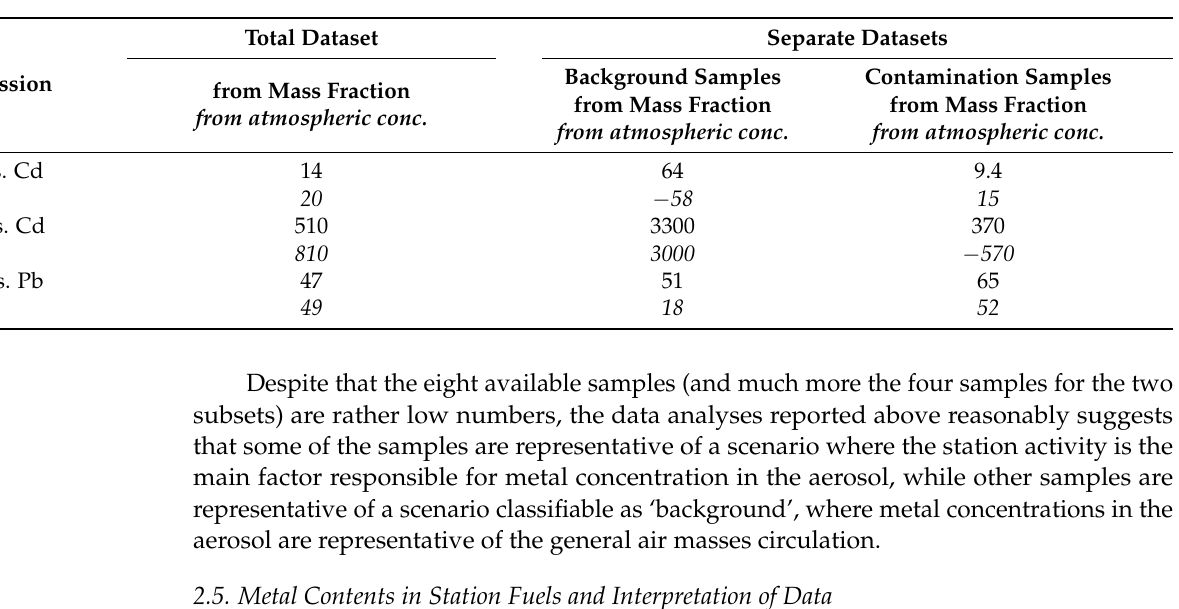
Table 5. Comparison of regression coefficients obtained from full and separate datasets. Mass fractions in µ g g − 1